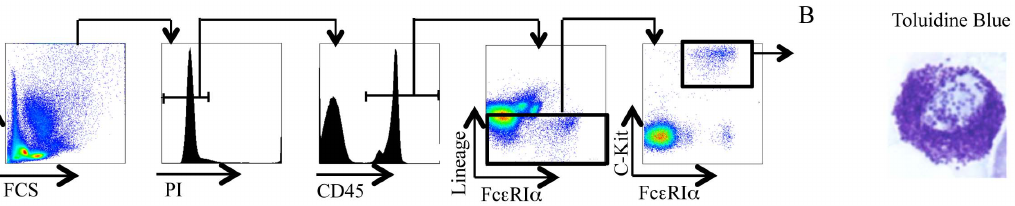
Figure 3. Flow cytometric analyses of BAL-MC. A. BALF cells were simultaneously stained with PI, anti-CD45, a mAb cocktail against lineage markers containing anti-CD3, anti-CD19, anti-CD56, anti-CD11b, and anti-CD11c mAbs, anti-CD117 (c-Kit), and anti-Fc e RI a and were analyzed by flow cytometry. B. Bronchoalveolar fluid MC (BAL-MC) sorted by flow cytometry were cytospinned onto glass slides, stained with Toluidine-blue and analyzed by microscopy ( 6 100).